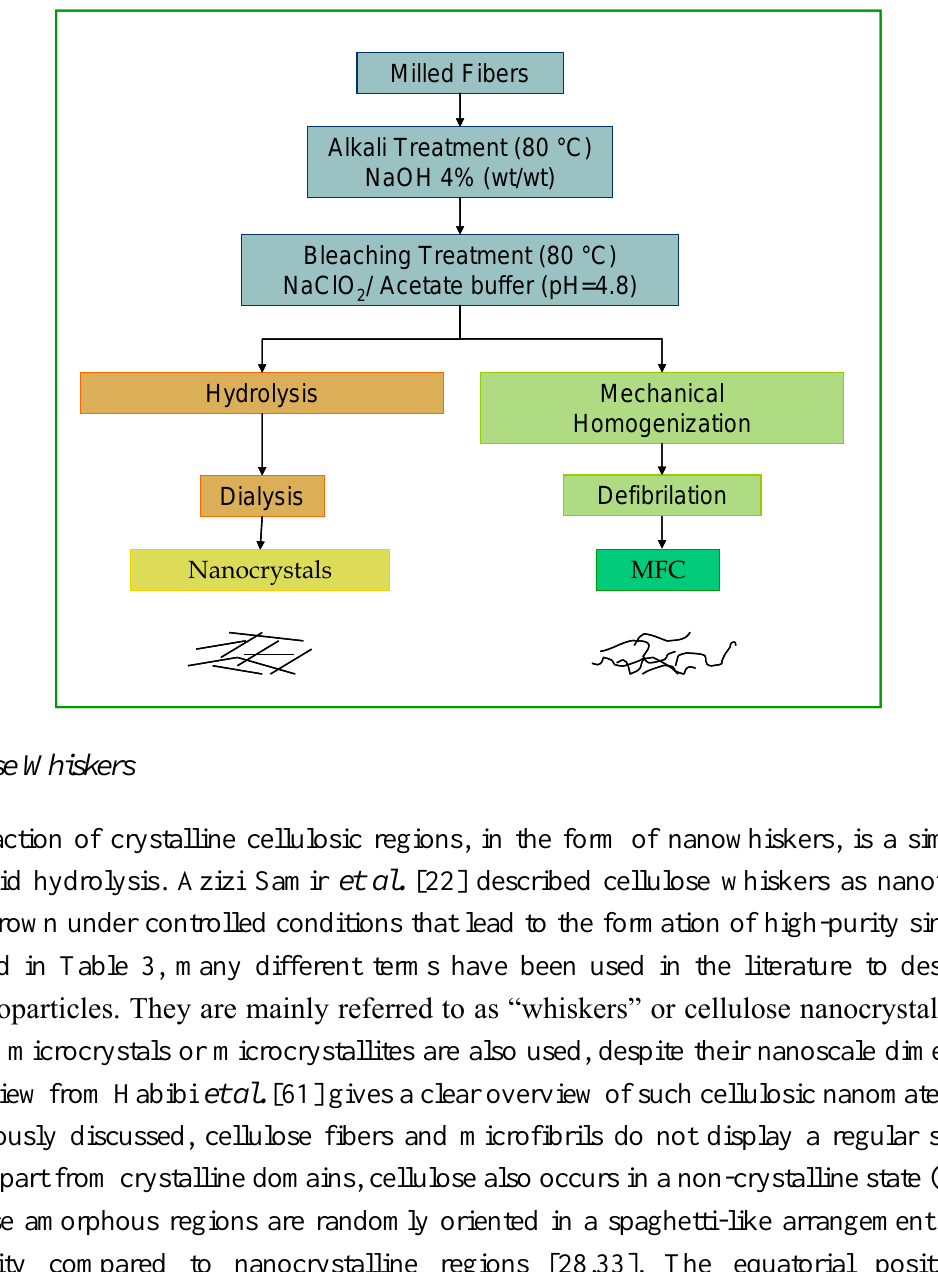
Figure 3. The main steps involved in the preparation of cellulose